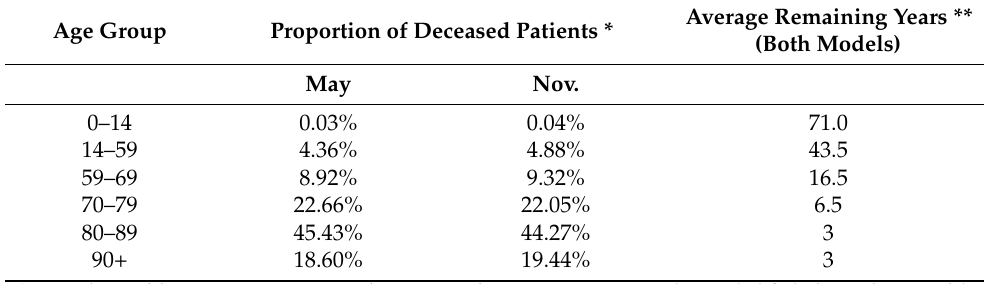
Table A11. Average remaining years by age group.